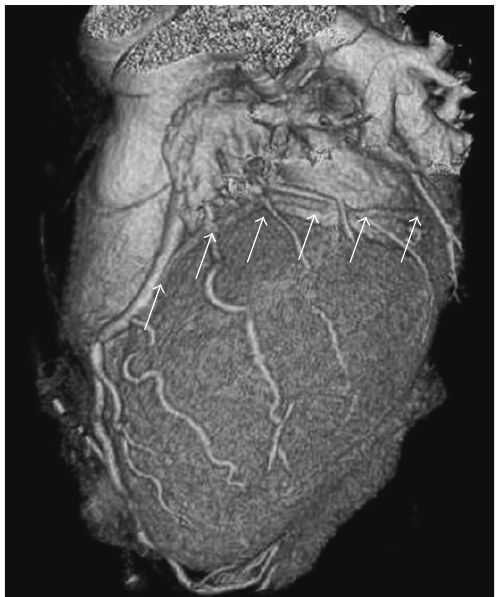
Figure 6: Multislice computed tomography of heart shows minor cardiac venous system